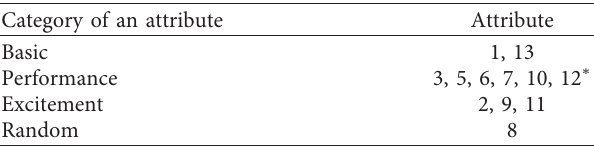
Table 6: Categories of attributes based on the rules presented in Section 3 (Ahmad et al. [22]).